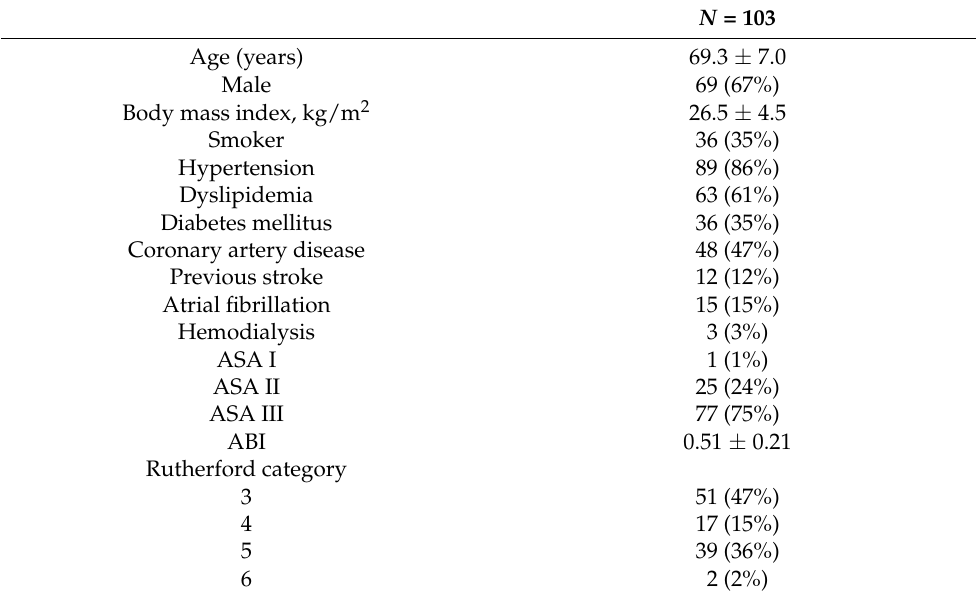
Table 1. Patient characteristics.